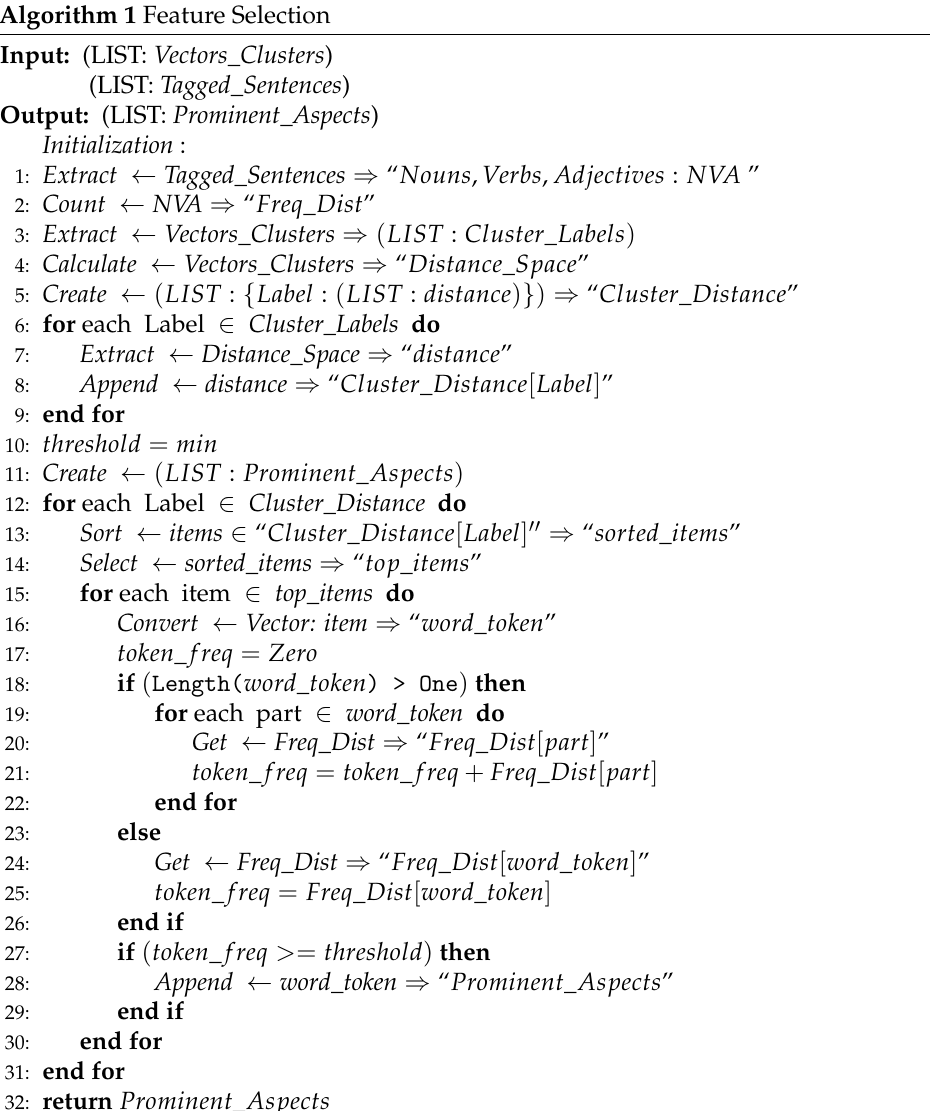
Algorithm 1 Feature